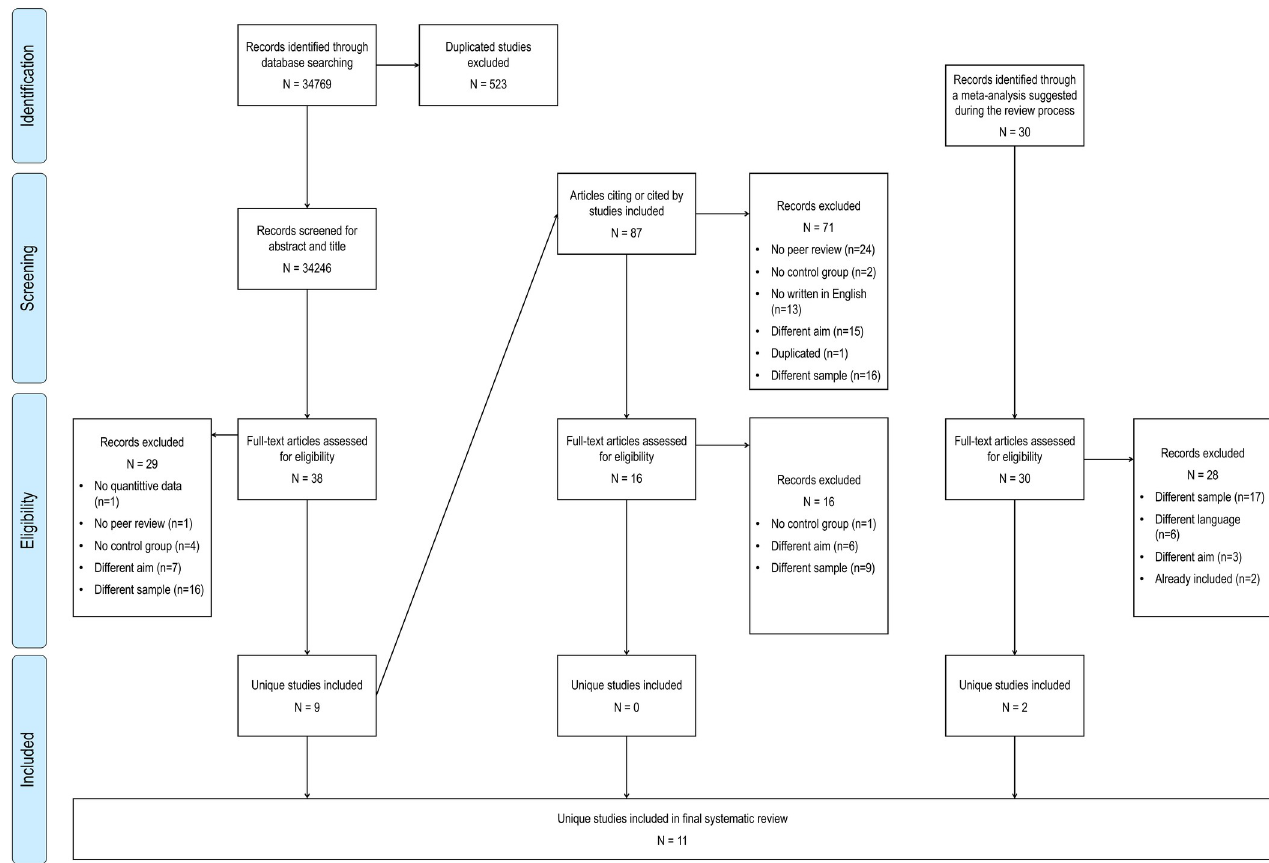
Fig 1. PRISMA flowchart. Flow of information through the different phases completed in the systematic